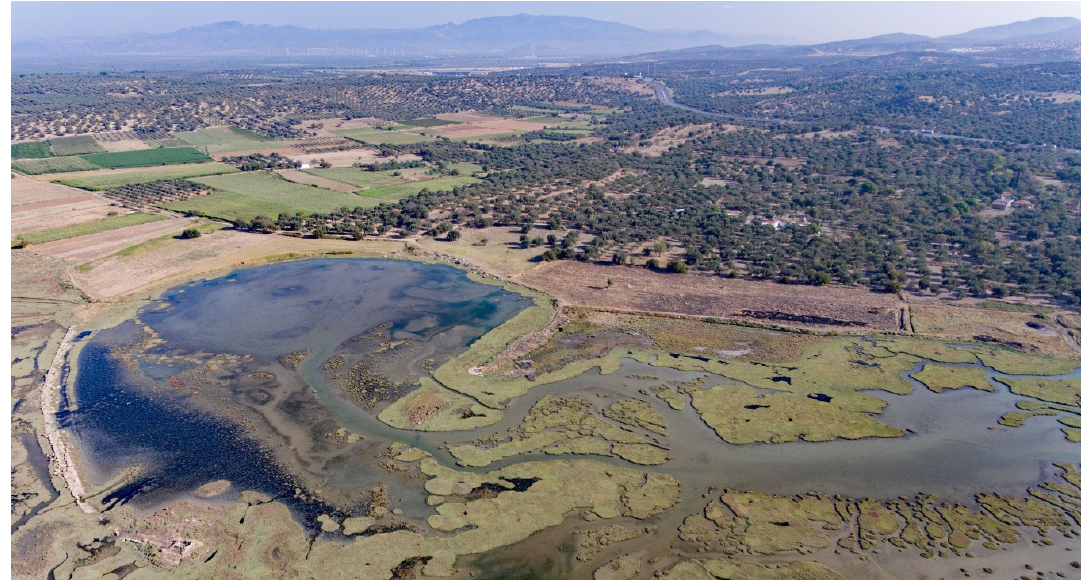
Figure 10. Foreground: Harbor basin of Elaia. Background: Highway leading past Elaia into the western lower Bak ı rçay Valley and to Bergama (Pergamon) similar to the ancient route B. From the north-western city gate of Elaia, a road paved with pebbles led through the north-western necropolis of Elaia to the southern slopes of the Bozyer Tepe [20]. Due to the higher sea level in antiquity [67] it can be assumed that the road ran through the necropolis [68] (pp. 185– 188), passing the tumulus on the Bozyer Tepe [69] (pp. 202–208), and continued to the bridge (bridge 1) over the Bak ı rçay River.